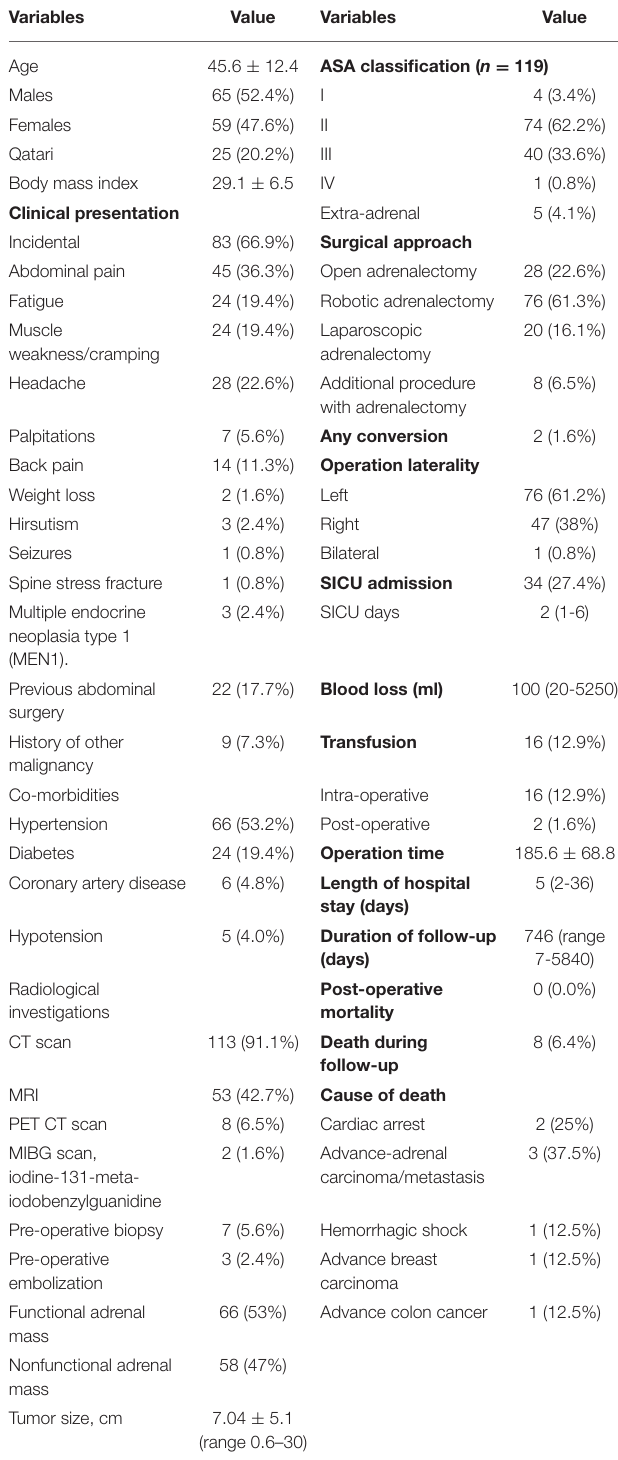
TABLE 1 | Demographics, clinical presentation, management, and outcome of patients with adrenal mass underwent surgical treatment ( n =